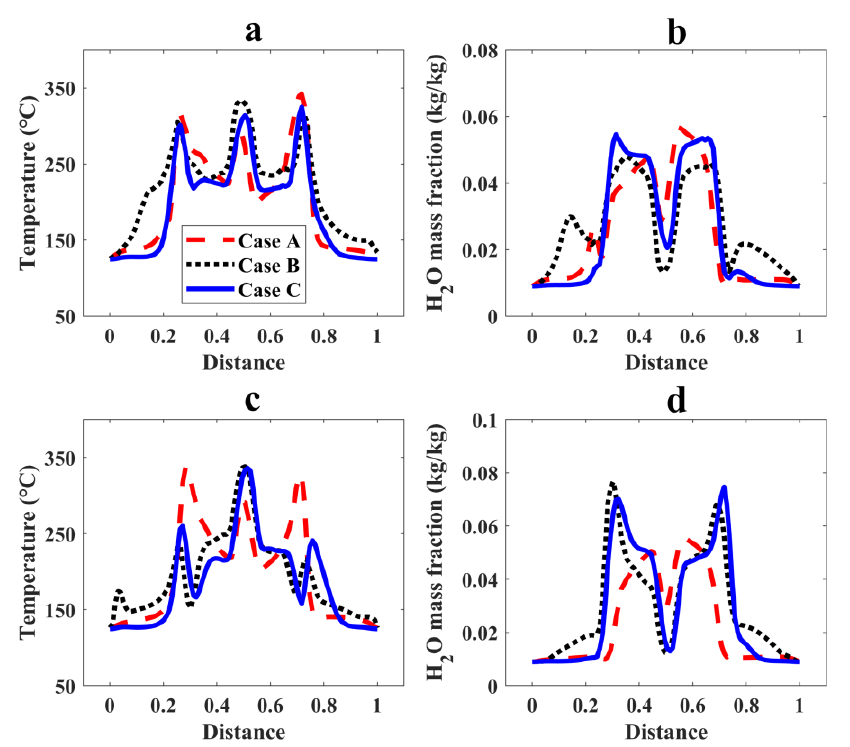
Figure 8. Radial temperature ( a , c ) and moisture ( b , d ) distribution at location z/Z = 0.55 for centerlines of X-Z ( a , b ) and Y-Z ( c , d ) planes.